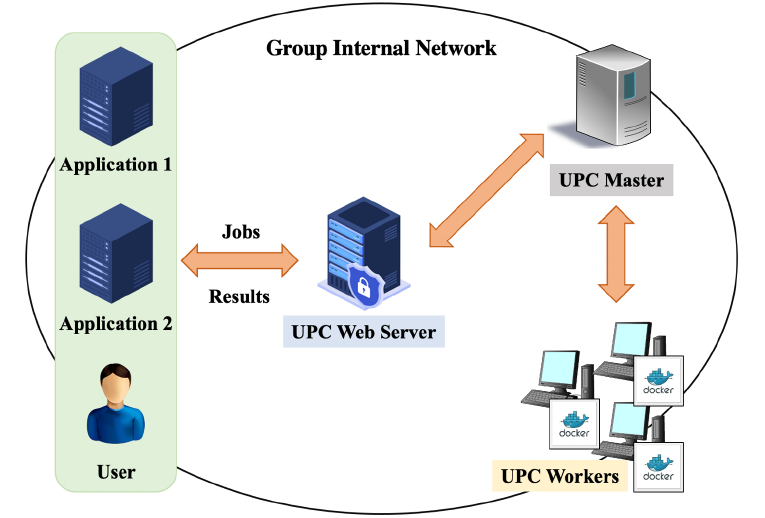
Figure 1. Overview of UPC